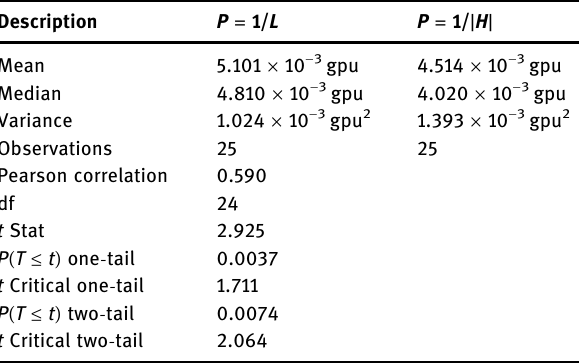
Table 3: t - Test: Paired Two Sample for Means using the samples of the mean errors of the benchmark derived from the adjustments based on weights ( 3 ) and ( 9